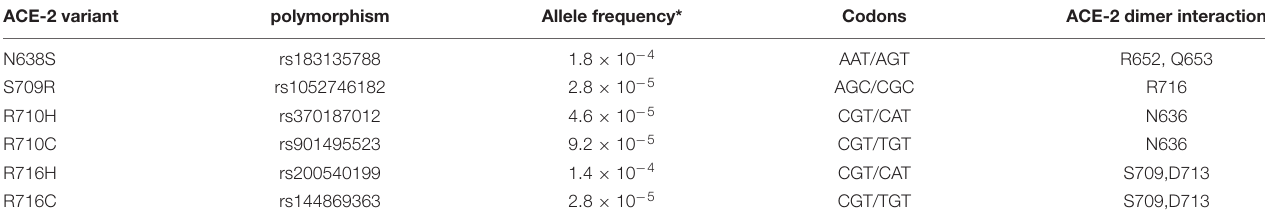
TABLE 2 | ACE-2 missense variants affecting residues involved in ACE-2 dimerization. ACE-2